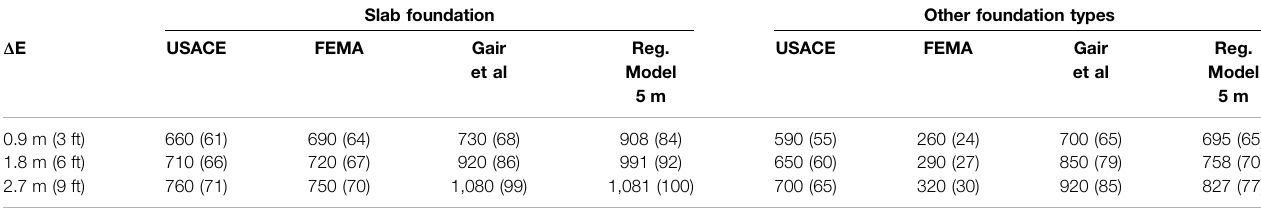
TABLE 1 | Elevation cost (cost/unit area) comparison between model 5 m and cost guidance, $/m 2 ($/ft 2 ).